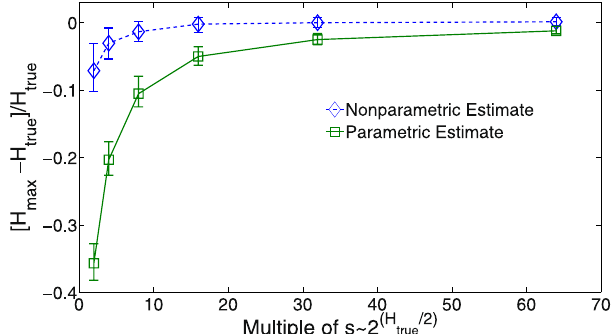
Figure 7. The fractional difference between the maximum entropy estimate and the true entropy using our nonparametric maximum calculated from the univariate and bivariate entropies, as well as estimating the maximum parametrically from the estimated bivariate probability distributions. One hundred distributions of three variables of the form of Eq. (11) were generated with the parameters h i and J i , j drawn from normal distributions with zero mean and standard deviation 0.1, with each variable having a cardinality of 5. The minimum number of samples needed, s ~ 2 H /2 , ranged from 4 to 12. The error bars indicate the 25% and 75%